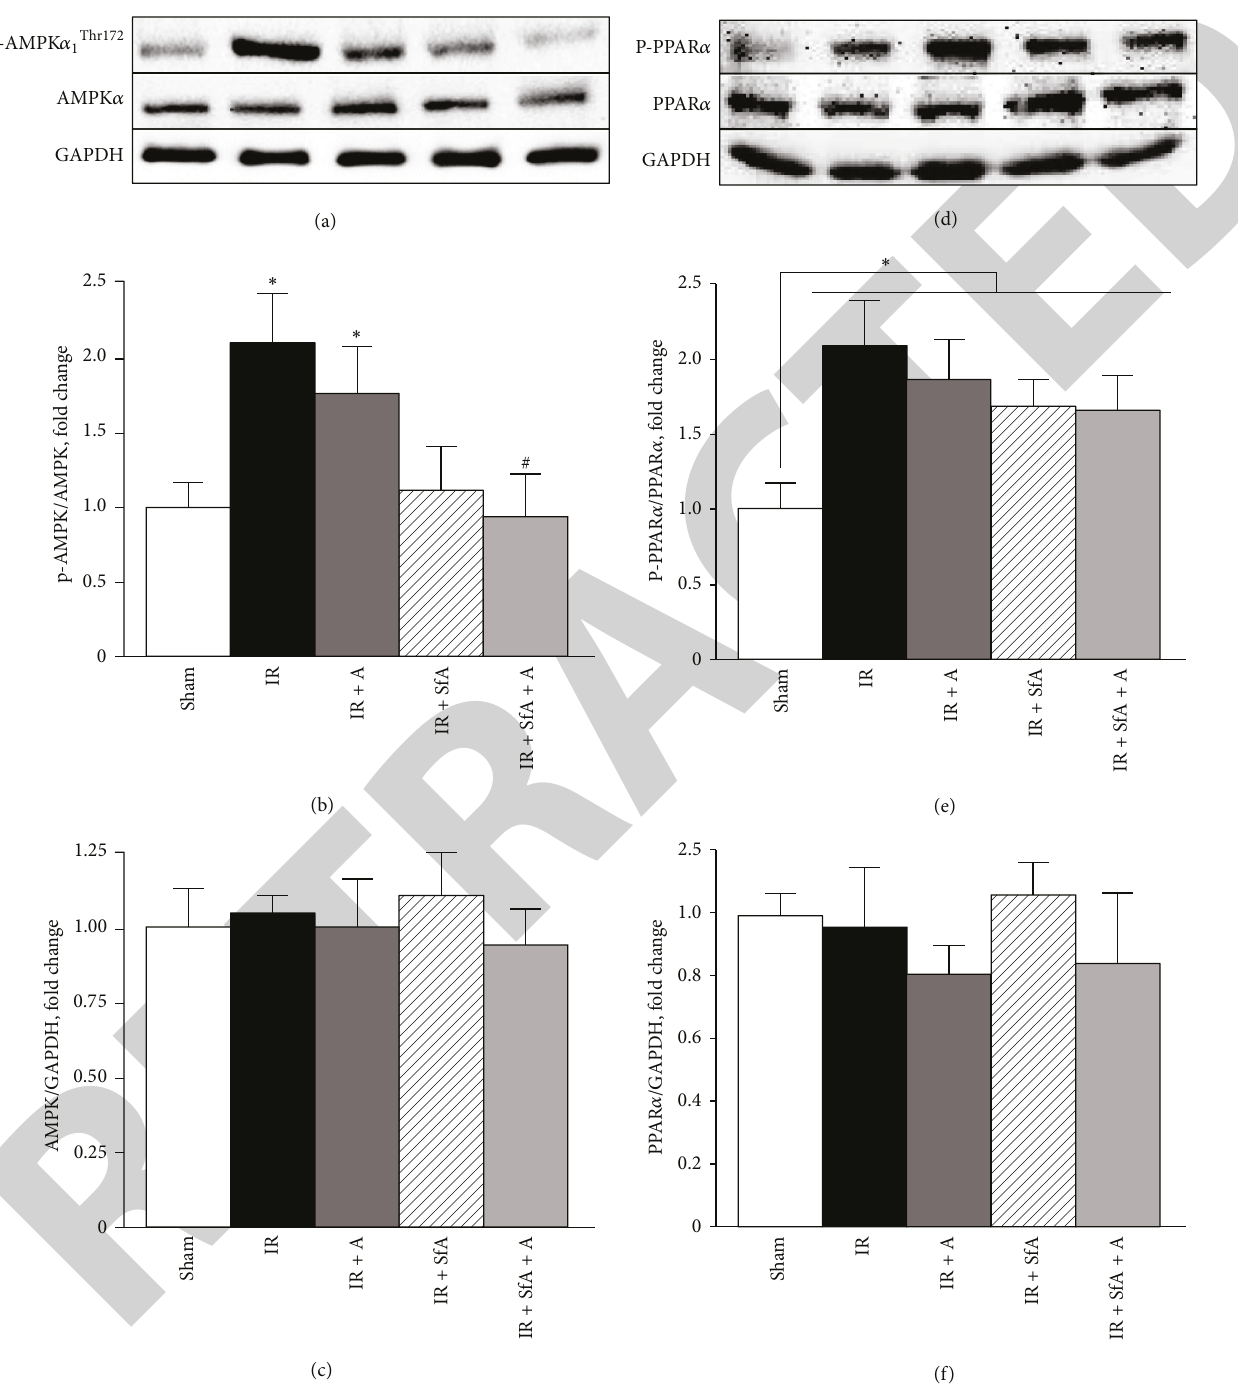
Figure 3: Protein levels of phosphorylated and total AMPK 𝛼 (a–c) and PPAR 𝛼 (d–f) in heart homogenates. Protein levels of P-AMPK 𝛼 1 Thr 172